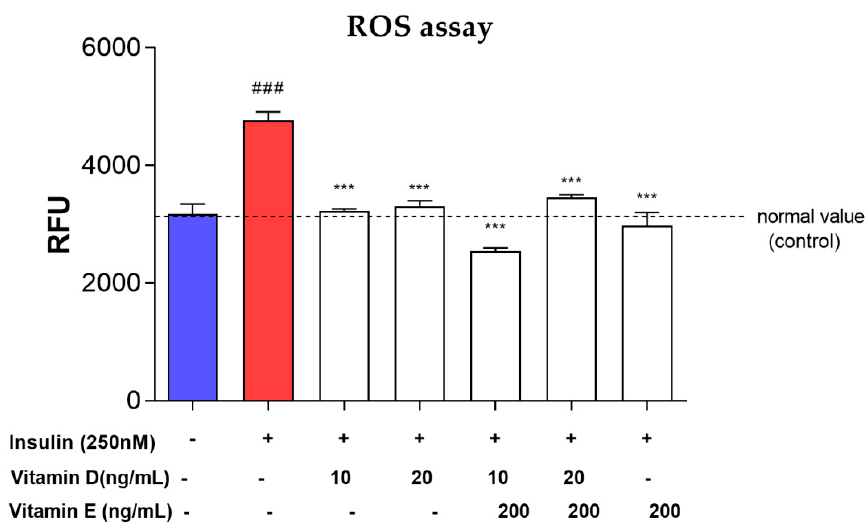
Figure 8. Reactive Oxygen Species (ROS) production level in insulin resistance model to determine the antioxidant potential. Red bar represents the ROS production level upon induction with 250 nM insulin for 16 h. White bar represents the ROS production level after treated with vitamin D and E for 24 h after induced with 250 nM insulin. Data were expressed as mean ± SEM of three independent experiments. Significant values were expressed as *** p < 0.001 compared to the negative control group and ### p < 0.001 compared to the control group.